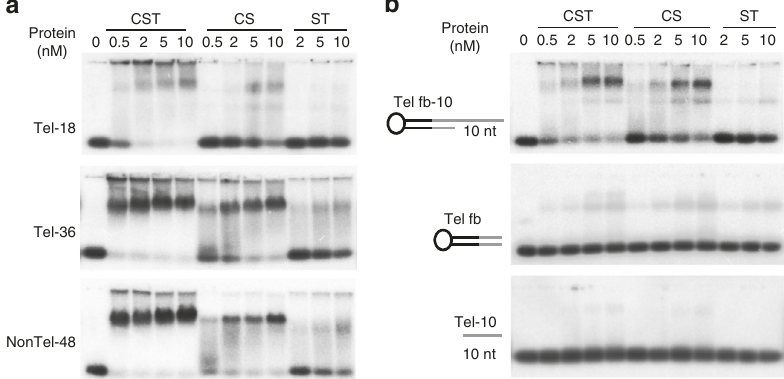
Fig. 5 CTC1-STN1 binds ssDNA and ss-dsDNA junctions with reduced af fi nity. a EMSAs showing CST, CS, or ST binding to 18 or 36 nt telomeric G-strand (Tel-18, Tel-36) or 48 nt non-telomeric (NonTel-48) ssDNA substrates. Reactions contained 0.1 nM DNA and the indicated concentrations of protein. b EMSAs showing CST, CS, or ST binding to ss-dsDNA telomeric junction substrate with 10 nt 3 ʹ overhang, same substrate lacking the overhang or 10 nt ssDNA of same sequence as the overhang. Black line: non-telomeric, gray: telomeric sequence; fb fold-back CST to position pol α to initiate C-strand synthesis, we asked (fold-back) oligonucleotide which self-hybridized to give 15 bp whether CS complexes also recognize ss-dsDNA junctions. dsDNA and a 10 or 18 nt 3 ʹ overhang 20 . The EMSAs indicated that CS bound both substrates with only modestly (5-fold) EMSAs were used to assess binding to two substrates: one had decreased ef fi ciency relative to the full CST complex (Fig. 5b, 10 nt telomeric G-strand overhang, the other had an 18 nt mixed Table 1, Supplementary Fig. 5b). As expected, af fi nity for the sequence overhang. Both substrates were formed from a single